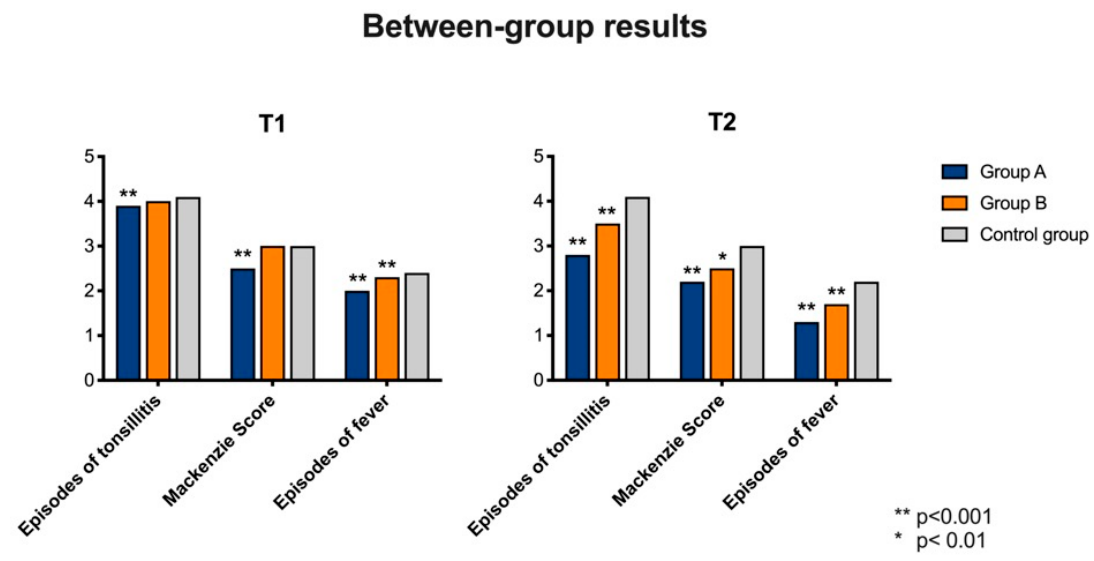
Figure 3. Di ff erences of the analyzed variables between Group A, Group B and Control Group. Figure 3